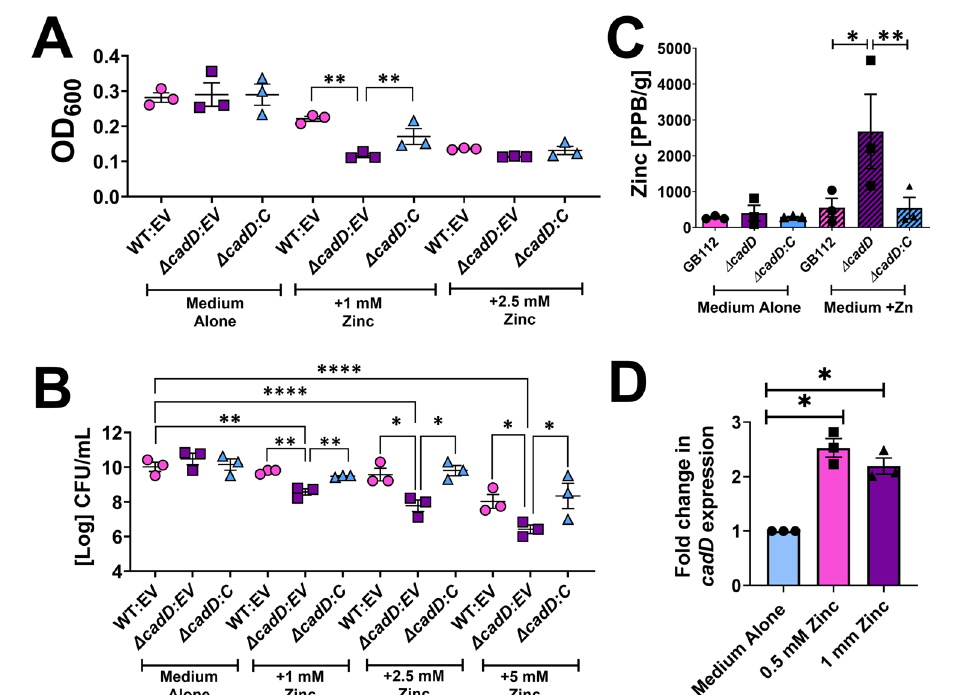
Fig. 3| The cadD locusisimplicated in zincstressresponseand survivalofzinc toxicity. A Analysis of wild-type parental GBS strain harboring the empty shuttle vector(WT:EV, pinkcircles), anisogenic Δ cadD mutant harboring the emptyshuttle vector ( Δ cadD:EV , purple squares), and complemented derivative ( Δ cadD:C , blue triangles) fi nal absorbance as determined by spectrophotometric determination of optical density at 600nm (OD 600 ) at 24h post-inoculation in increasing con- centrationsofzinc(1mMand2.5mM). B Analysisofbacterialviability(LogCFU/mL) in medium alone or supplemented with zinc (1mM, 2.5mM, or 5mM). Bacterial cultures were grown overnight and subjected to serial dilution and plating